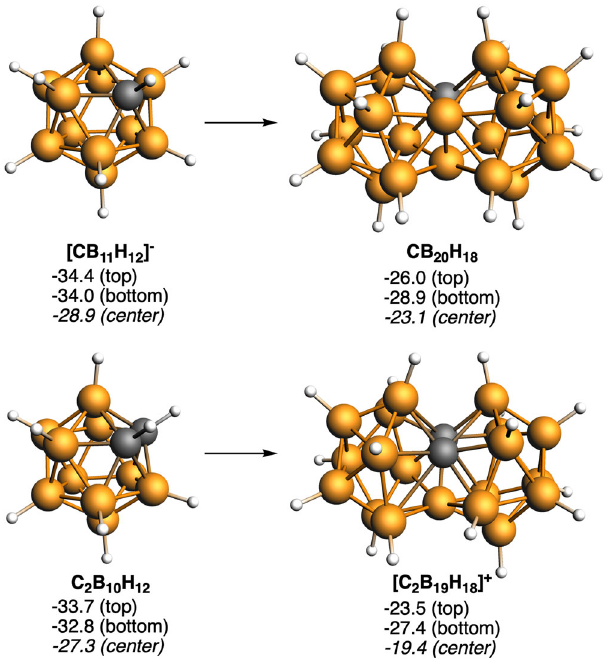
Fig. 3 3D/3D systems formed from [CB 11 H 12 ] − and C 2 B 10 H 12 . Computed NICS (in ppm) at the center of different fi ve-membered rings and at the center of each cluster are enclosed. Boron atoms in orange, C atoms in gray, and H atoms in